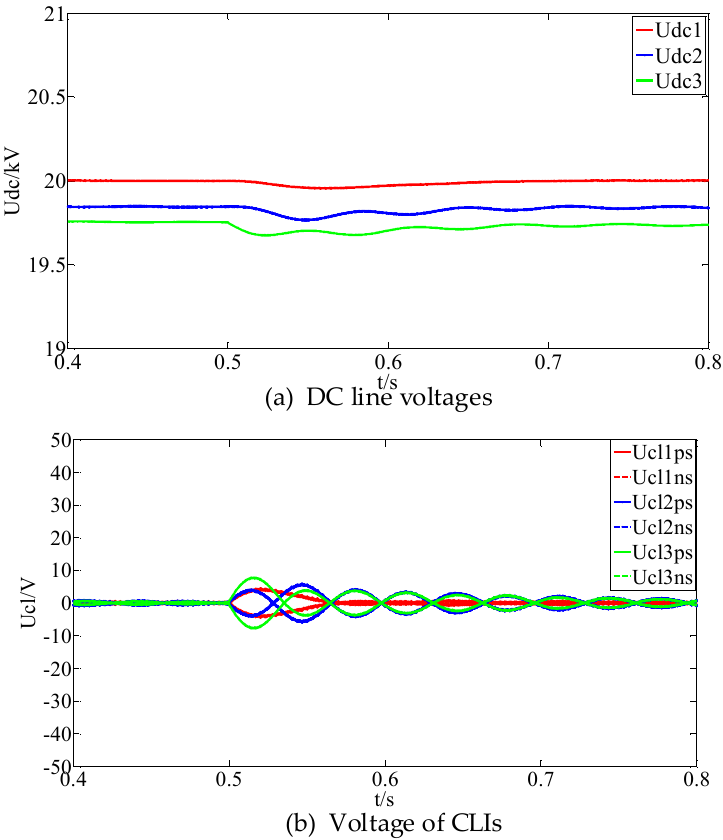
Figure 13. Voltage waveforms of the DC line voltages and the CLIs during the voltage disturbance.